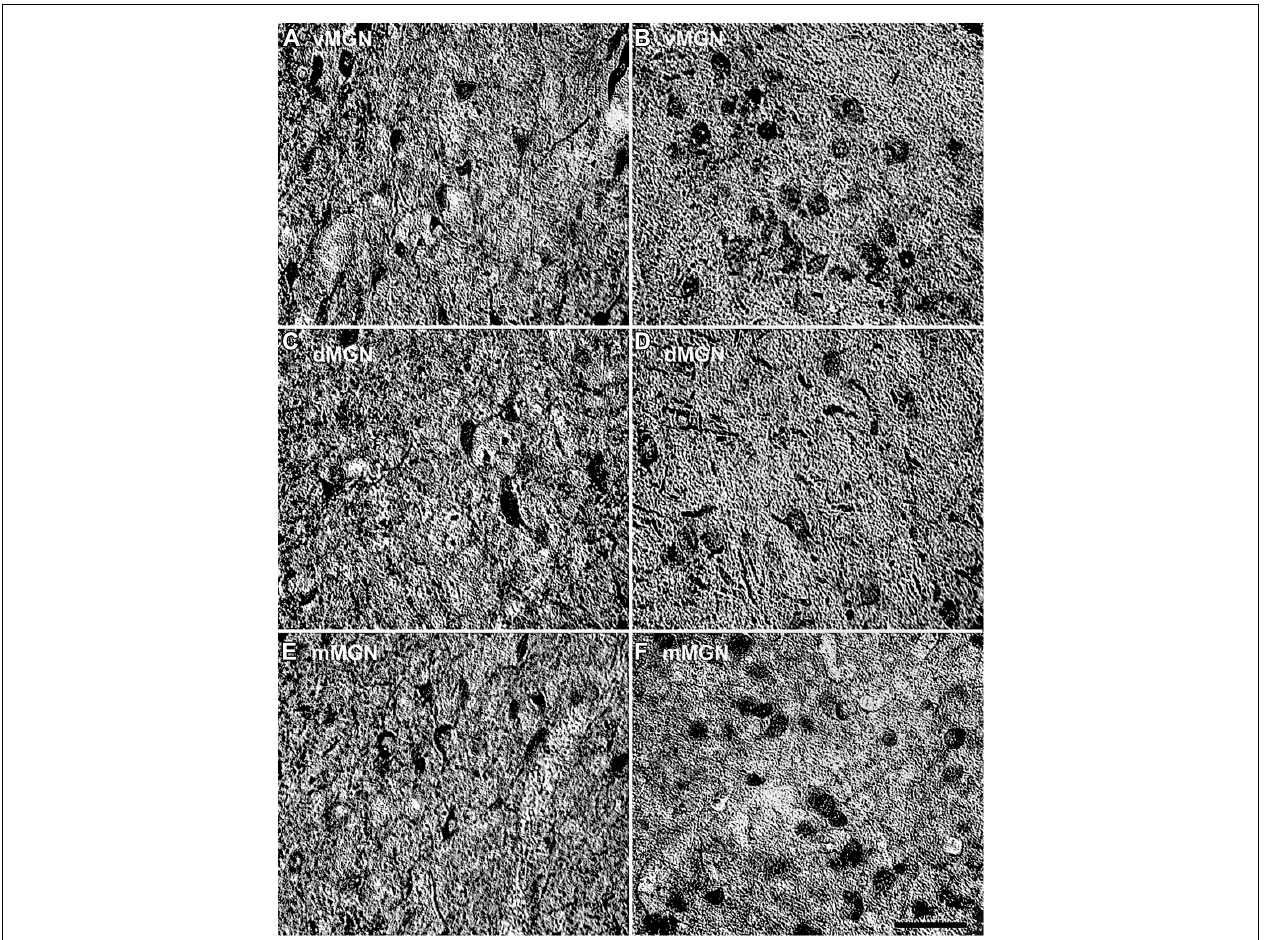
FIGURE 2 | Comparison of parvalbumin positive cell density of the MGN between the 15- and 35-year-old animals. Comparison of micrographs from a (A) 15 year old vMGN and (B) 35 year old vMGN reveals apparent age-related increases in the number of stained cells. However, when comparing a (C) 15 year old dMGN with a (D) 35 year